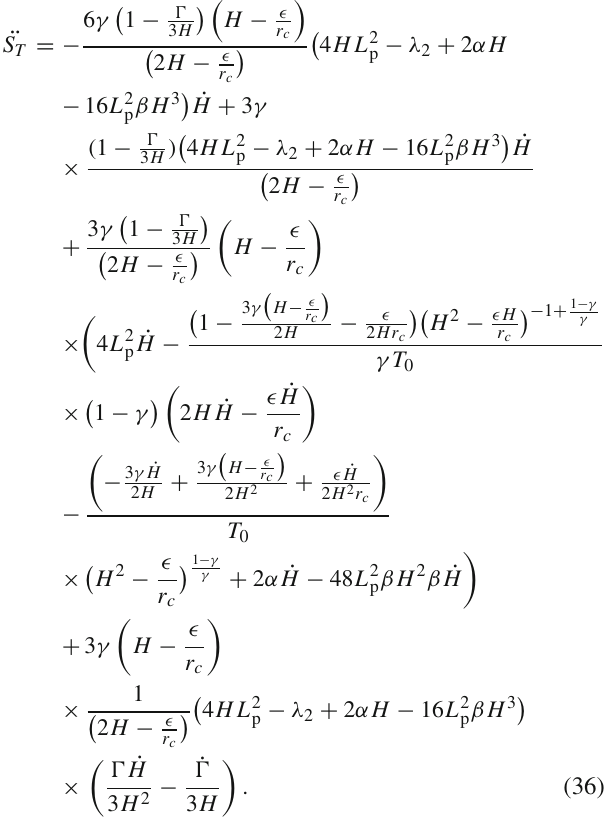
¨ S T and γ for three values of T by fixing the The plot between constant values q = − 0 . 53, α = − 2 , β = − 0 . 000000001 and L p = 1 as shown in Fig. 5. It can be seen that thermo- dynamical equilibrium is obeying the condition all values of T which leads to the thermal equilibrium.